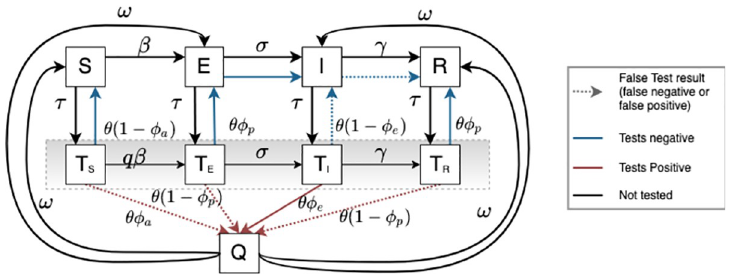
Fig 1. Schematic of the COVID-19 epidemiologic model. Individuals in the population start as susceptible ( S ) and become exposed ( E ) at a rate β . Exposed individuals become infectious ( I ) at a rate σ , and recover (R) at a rate γ . Simultaneously, surveillance testing occurs at a rate proportional to the population make up, and individuals awaiting test results are in a “leaky” quarantine. Tested susceptibles ( T S ) can become exposed ( T E ), then infectious ( T I ), and can infect susceptibles (both S and T S ). Since tested infectious individuals ( T I ) are quarantining, their infectiousness is reduced by a factor q . Likewise, since tested susceptibles ( T ), are also quarantining, their susceptibility is reduced by a S factor q . Individuals who test positive are isolated (Q). We assume isolation is perfect, and thus individuals can only progress through their disease process ( Q - > Q - > Q ); susceptibles who are isolated cannot become infected and E I R infected individuals who are isolated cannot cause infections. After the isolation period is over (14 days in the standard condition), individuals are returned to the general population, retaining their current disease state. Antigen and RT-PCR tests have a specified positive ( ϕ e ) and negative percent agreement ( ϕ p ) with viral culture (see text). ϕ a is 0.0001, representing imperfect test specificity. Note that we use positive percent agreement for tests of infectious individuals ( I ) and negative percent agreement for both exposed ( E ) and recovered ( R ) individuals, as it has been shown that RT-PCR may detect infection among individuals who are no longer infectious [19]. Here, the color and line-type of the arrows indicate whether or not the test was “correct” or “incorrect” with respect to infectiousness, with dotted lines indicating incorrect test results (i.e., false negative or false positive), red lines indicating a positive test, blue lines indicating a negative test, black lines indicating that no test result was